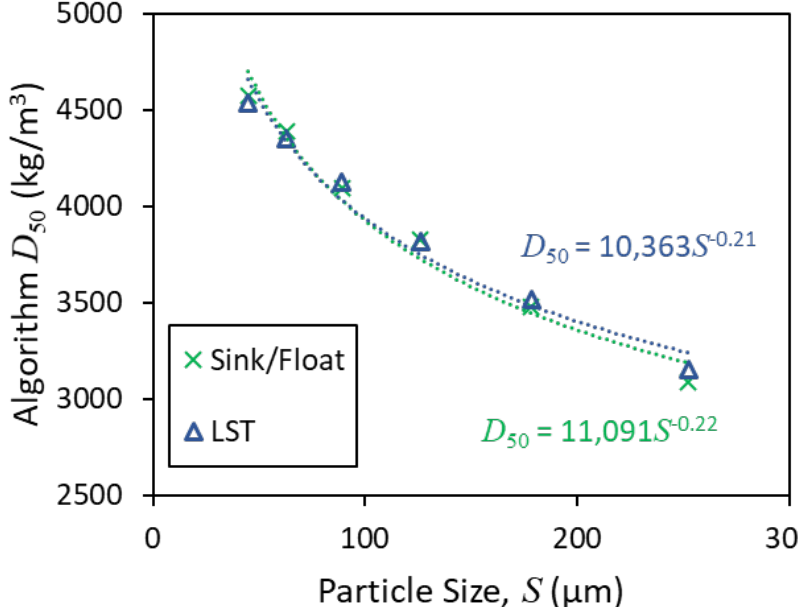
Figure 2. Variation in separation cut point, D 50 , as a function of particle size. The algorithm was applied to raw data based on the sink/float test and LST flow fractionation data. The LST method has determined the cut point values with remarkable accuracy across the entire size range. RC separation z = 3 mm; RC flow fractionation z = 1.77 mm.